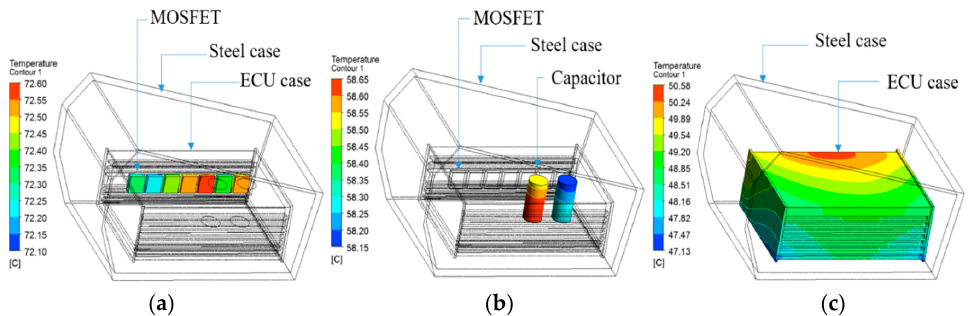
Figure 12. Temperature distribution of the MOSFET, capacitor and ECU when ambient temperature is 40 °C: ( a ) Temperature distribution of the MOSFETs; ( b ) Temperature distribution of the capacitors; ( c ) Temperature distribution of the heatsink (ECU case).